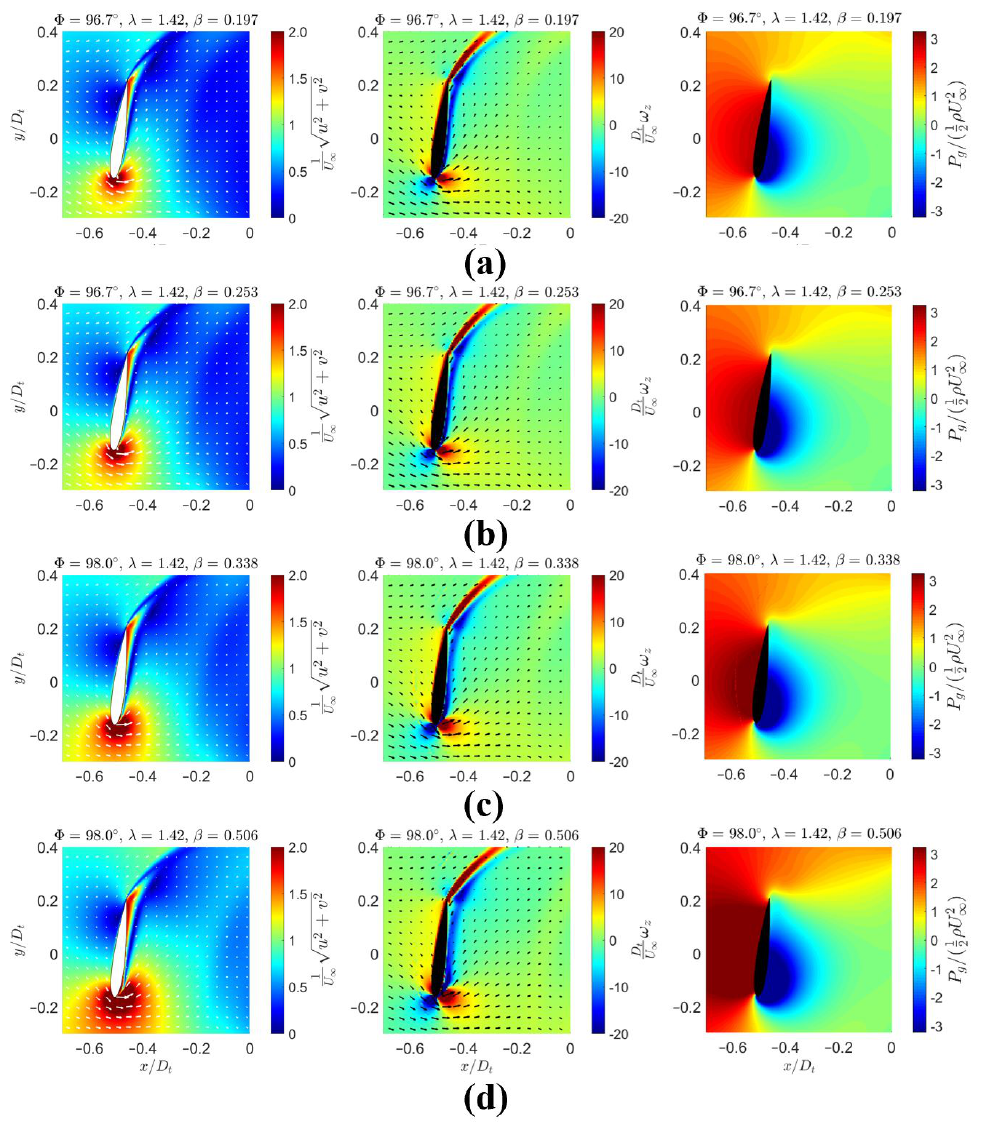
Figure 9. The velocity, vorticity, and pressure fields around one of the turbine blades at its maximum torque angle of 4 blockage ratios: 19.7% ( a ), 25.3% ( b ), 33.8% ( c ), and 50.6% ( d